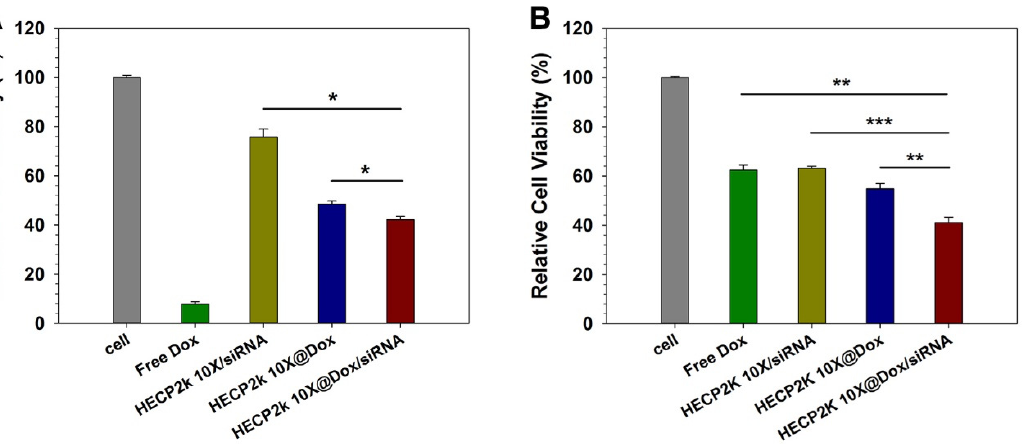
Figure 8. Relative cell viability for free Dox, HECP2k 10X/siRNA, HECP2k 10X@Dox/siRNA com- plexes at a high concentration of Dox and siRNA in ( A ) HeLa and ( B ) HepG2 cells. Statistical analysis was performed through one-way ANOVA and Bonferroni post hoc test. Statistical significance is presented as follows ( p < 0.05 *, p < 0.01 **, p < 0.001